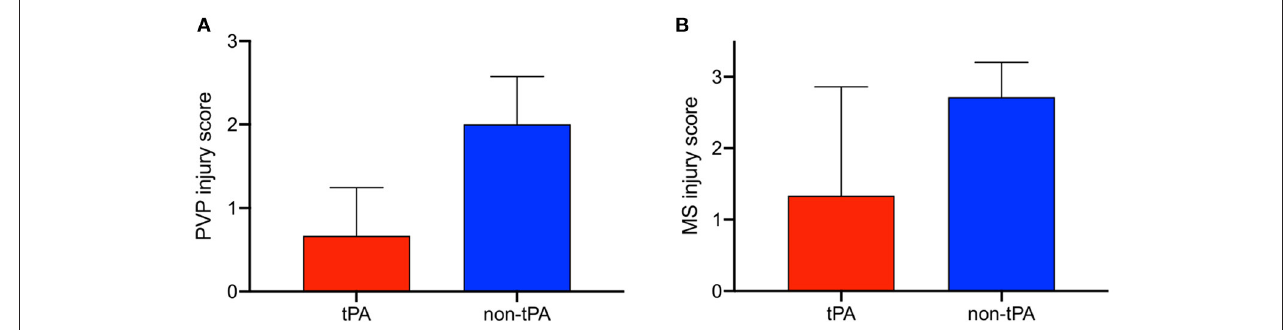
FIGURE 4 | Difference in bile duct injury scores before and after 12h of normothermic machine perfusion (NMP) between whole, non-viable tPA livers (red) and whole, non-viable control livers (blue) for peribiliary vascular plexus (PVP) injury and mural stroma (MS) injury. tPA livers exhibit less (A) PVP injury and (B) MS injury. Error bars represent standard deviation.